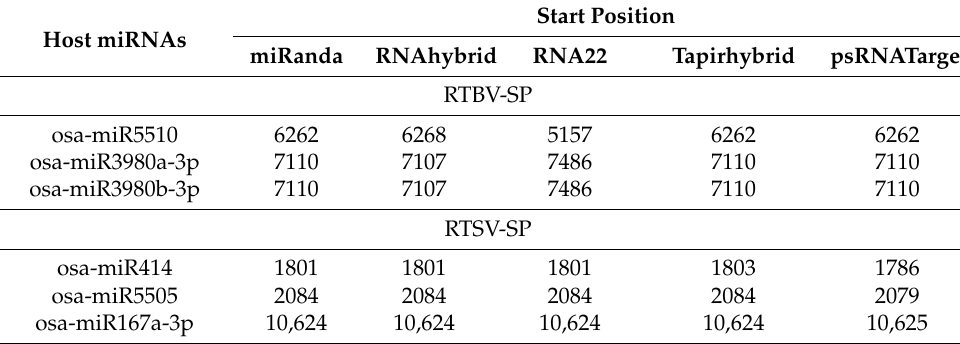
Table 4. The best host-derived miRNAs target the RTBV and RTSV genome, and their target position identified by all